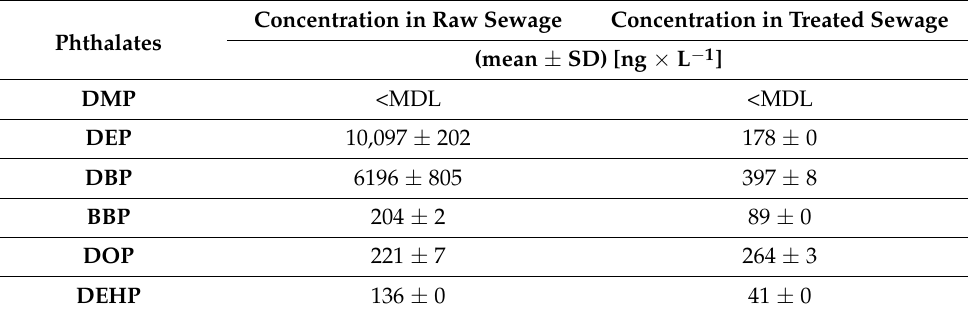
Table 4. Concentrations of target compounds in raw and treated sewage samples collected from the studied full-scale MWWTP supported by CWs, determined using the developed SPE–GC–MS(SIM) method (n =